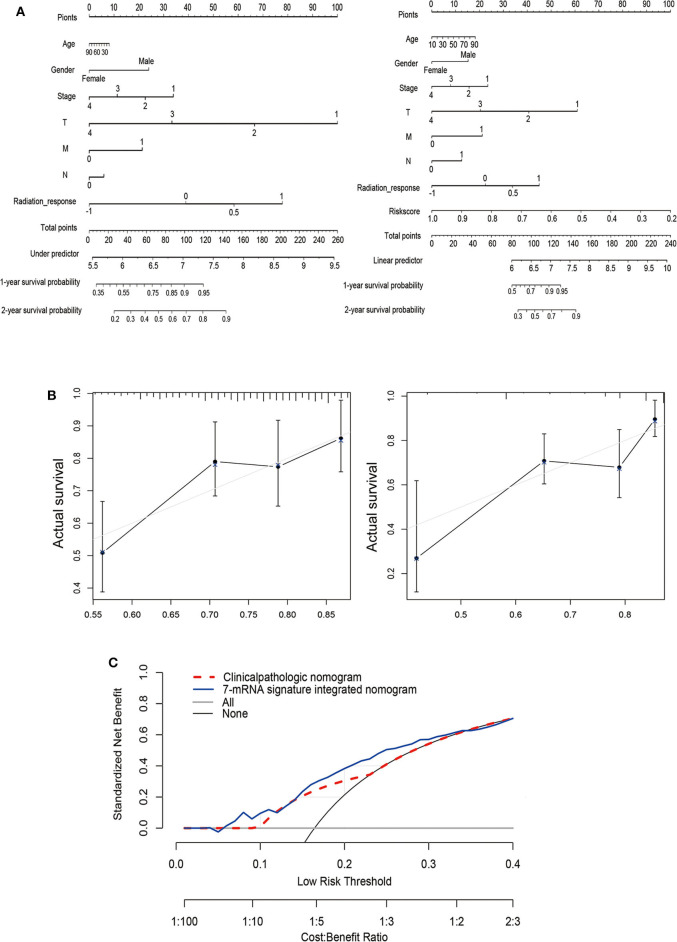
Establishment of a nomogram based on clinical characteristics and the 7-mRNA-gene signature. (A) Nomograms combined without (left) or with (right) the 7-mRNA-gene signature to predict 1- and 2-year PFS probability in THCA. (B) Calibration curves for the clinicopathologic nomogram and the 7-mRNA-signature integrated nomogram calibrate each model based on the consistency between the predicted and observed results. (C) Decision curve analysis of this nomogram.